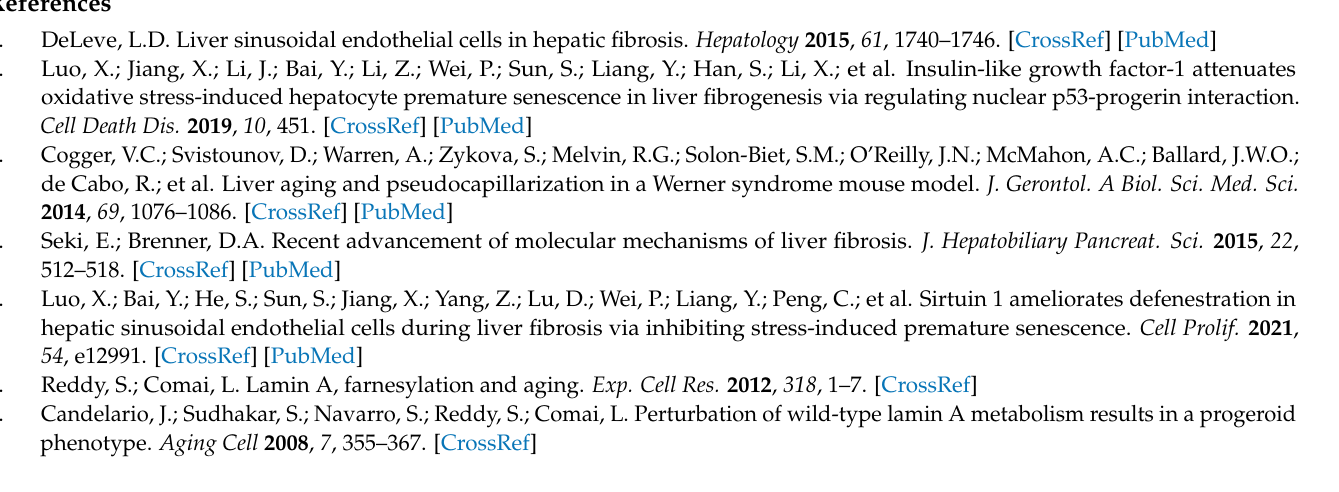
Figure S4: H 2 O 2 up-regulates NOX2- and NOX4-dependent oxidative damage to induce defen- estration in LSECs; Figure S5: Antioxidants promote progerin-related nucleopahgy and prevent autophagic degradation of cytoplasmic Cav-1 via inhibiting oxidative damage; Figure S6: Inhibition of autophagy with 3-MA rescues Cav-1 level, rather than affects the levels of progerin and Lamin B1; Figure S7: Overexpressing SIRT1 inhibits oxidative stress-induced Cav-1